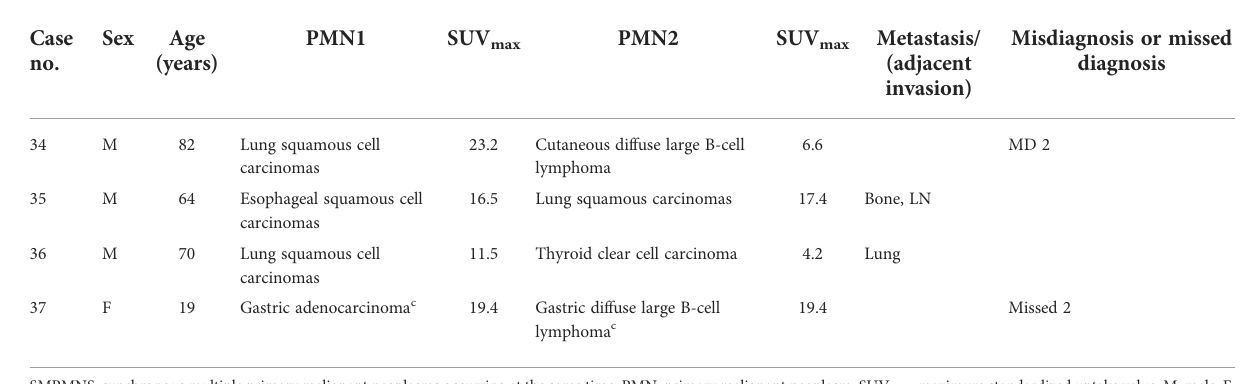
Diagnostic performance: CI VS . 18 F-FDG PET/CT